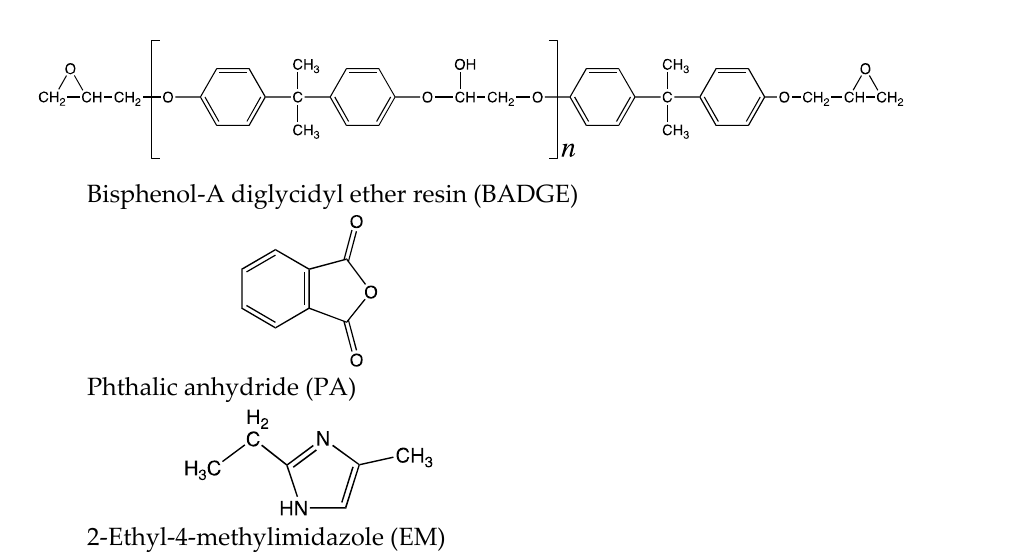
Figure 8a, inset i ) or at the maximal magnetic field density ( H ‐ field; position (ii) in Figure 8a, inset i ) within the waveguide.